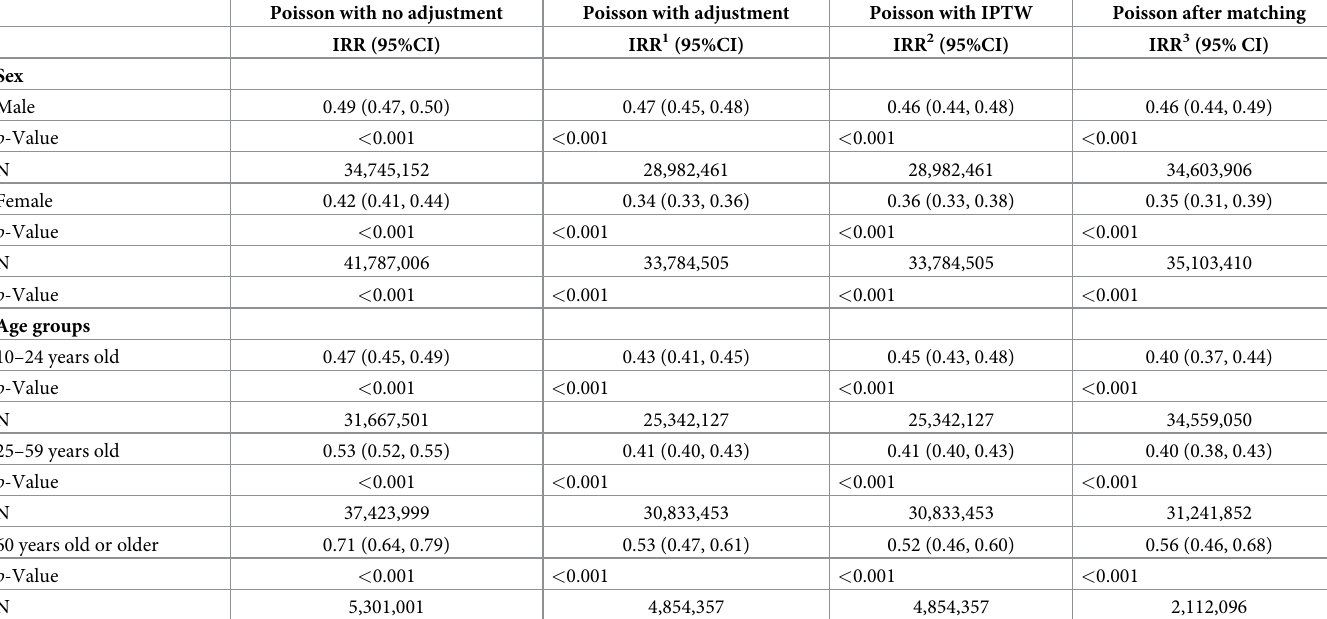
Table 4. Suicide IRR for BFP participation in the matched and original cohorts by sex and age groups from 2004–2015. Poisson with no adjustment Poisson with adjustment Poisson with IPTW Poisson after